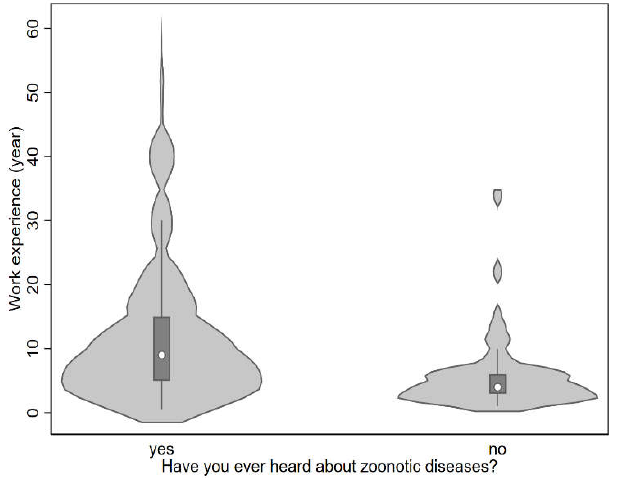
Figure 2. Years of experience working in the chicken meat production chain, by whether respondents have heard of zoonotic diseases or have never heard of them before.